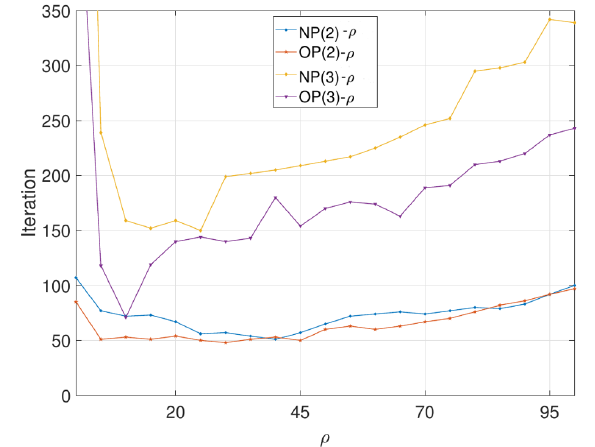
Figure 2. Iteration number v.s. dual penalty factor ρ for given residual accuracy. (NP(2) and NP(3) are from